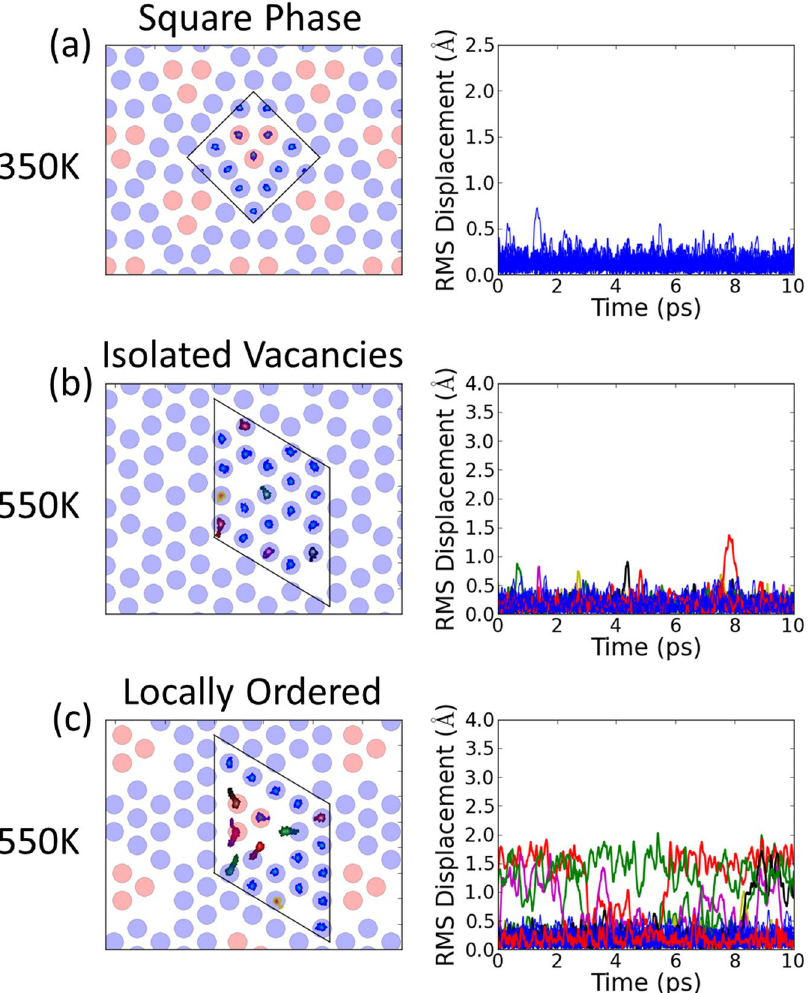
Figure 4. Molecular dynamics simulation of diffusion in Na x CoO 2 in the square and disordered phases. The left-hand panels show the trace of sodium positions over the duration of the simulations (the boxes show the cells used in the MD simulations), and the right-hand panels show the root-mean-square displacement of sodium ions as a function of time. The different colours give trajectories for different ions, with the same colour for a given ion in successive panels from left to right. ( a ) For the square phase the tri-vacancy clusters are well separated, and there are very few hops compared to the stripe phase. ( b ) For isolated 2 d vacancies there is negligible hopping of ions. ( c ) In the disordered phase the introduction of a vacancy next to a tri-vacancy cluster results in multiple hops. For interconnected pathways of the type shown in Fig. 2(c) bulk translational diffusion is predicted by consideration of the available pathways, though the timescale of these simulations is insufficiently long to demonstrate this